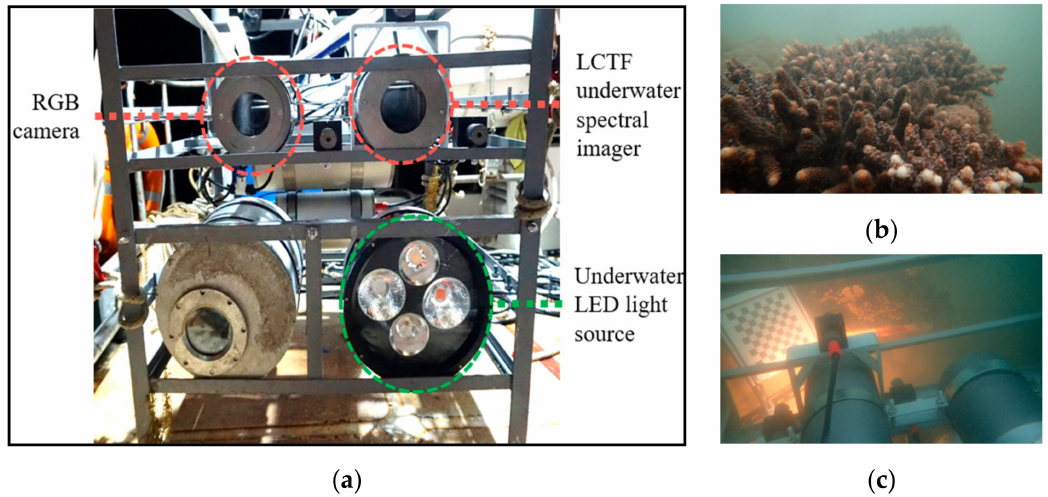
Figure A5. ( a ) Underwater spectral imaging system; ( b ) Imaging Acropora sp; ( c ) Imaging